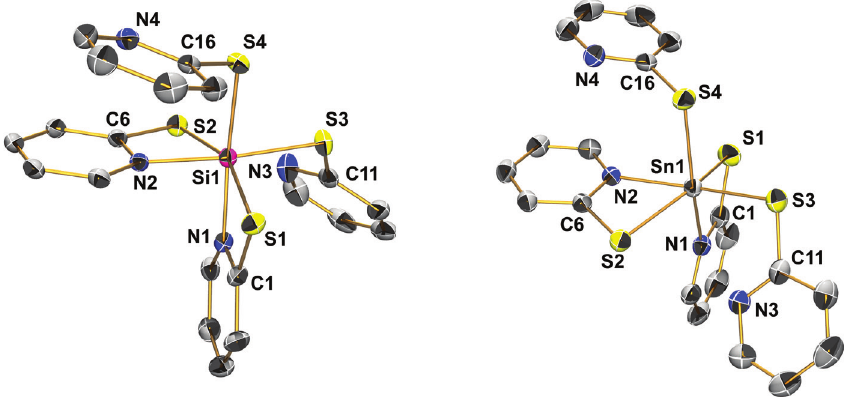
(E = Si, Sn) in their crystal structures. Figure 2 Molecular structures of E(PyS) 4 ORTEP/POV-RAY diagrams (Farrugia, 1997; POV-RAY 3.6, 2004) with thermal displacement ellipsoids are shown at the 50% probability level. Selected atoms are labeled and hydrogen atoms are omitted for clarity. (Note: The labels of S3,C11,N3 and S4,C16,N4 in compound Sn(PyS) do not correspond to the labels in the CIF but have been assigned for consistence with the corresponding bonds and angles in Table 3.)